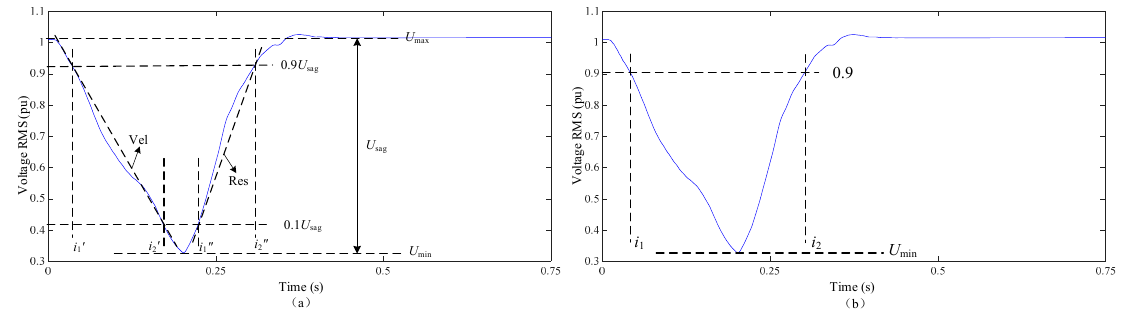
Figure 6. Voltage sag characteristic parameters.